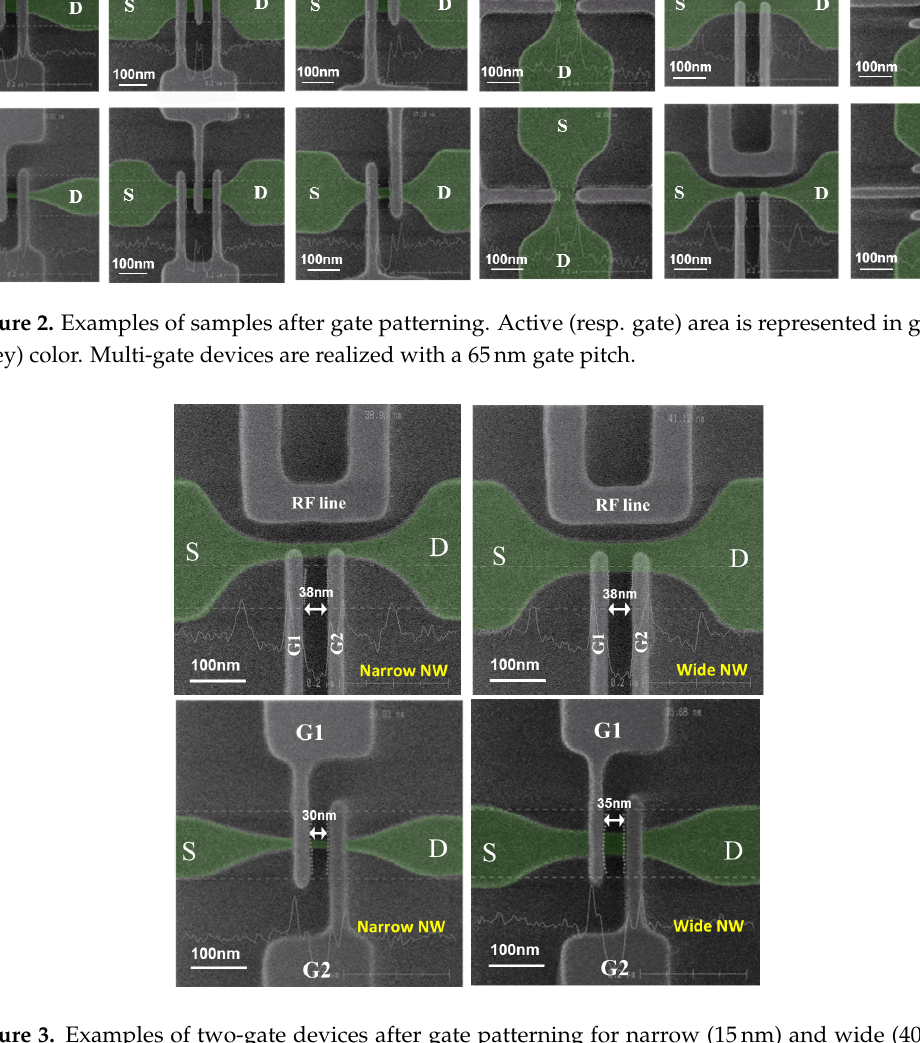
Figure 3. Examples of two-gate devices after gate patterning for narrow (15nm) and wide (40nm) nanowire width. Active (resp. gate) area is represented in green (grey) color. Top : Scanning electron micrograph of two-gate device. The two gates partially overlap the active area and a RF line is located in the vicinity of the Si islands; Bottom : Scanning electron micrograph of two-gate device used for electron pumps. The minimal spacing between gates is